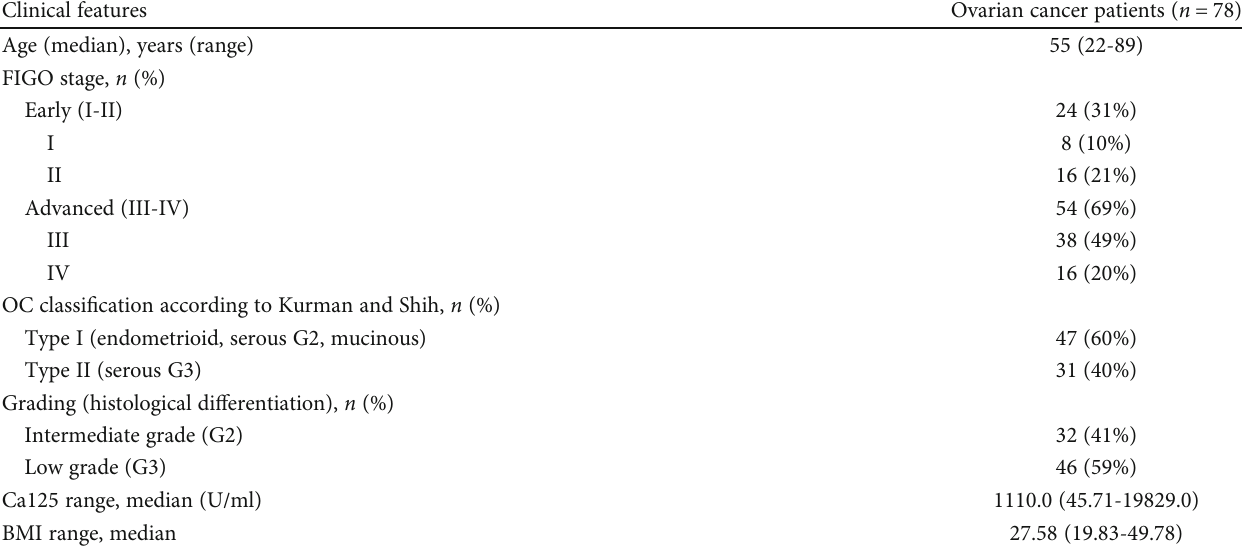
Table 1: Clinical characteristics of OC